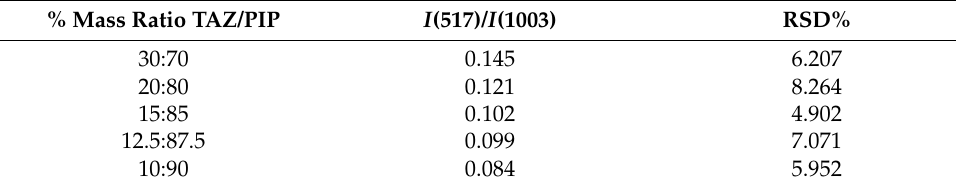
Table 3. Mean peak height ratio, I (517)/ I (1003), and relative standard deviation (RSD) values corresponding to the six measurements performed, for each one of the standard mixtures placed in the commercial glass bottle.